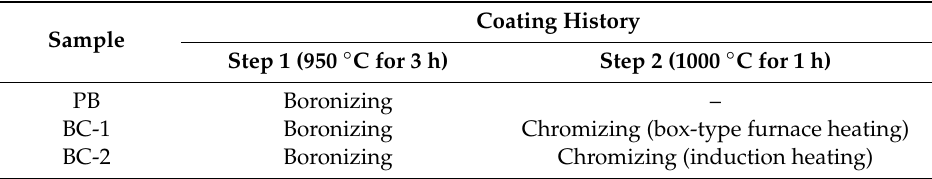
Table 1. Coating histories of various samples in this study.